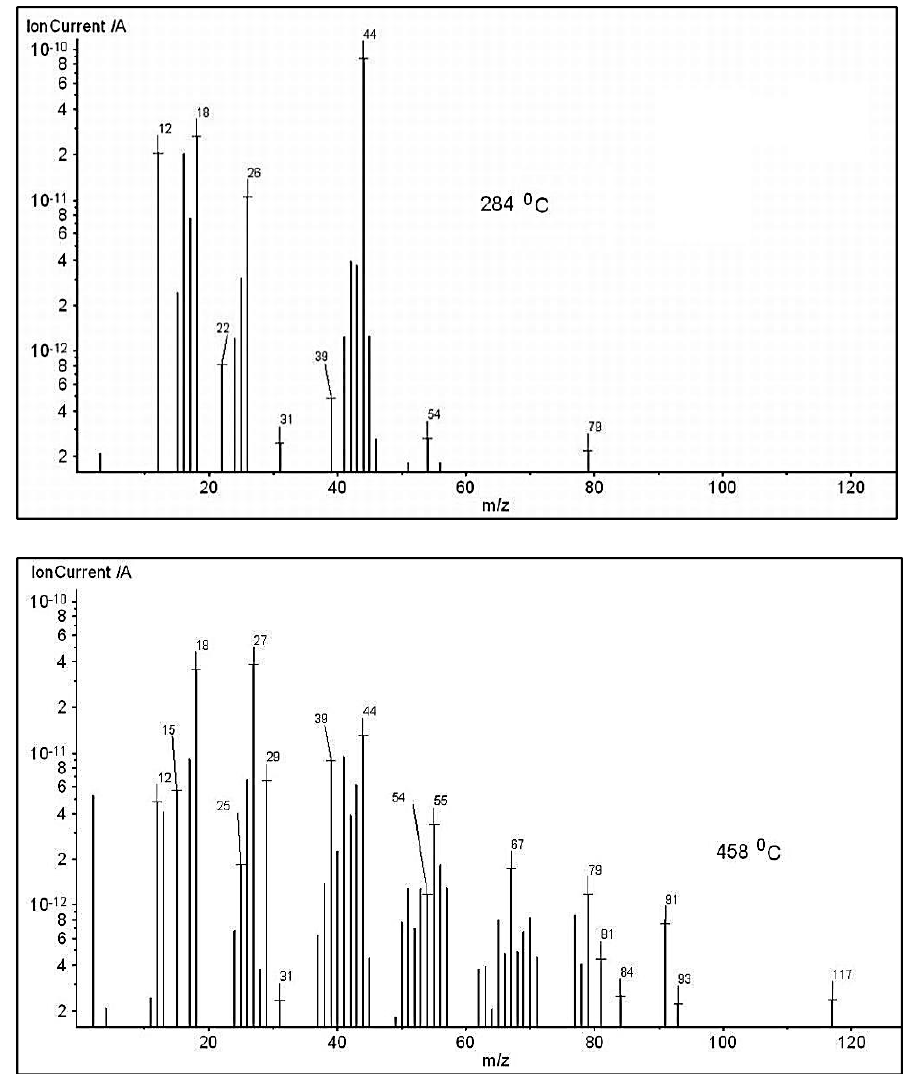
Figure 10. MS spectra of thermal degradation products recorded at 10 °C min − 1 (at the maximum temperature of the evolved gases) for PEBSA copolymer.